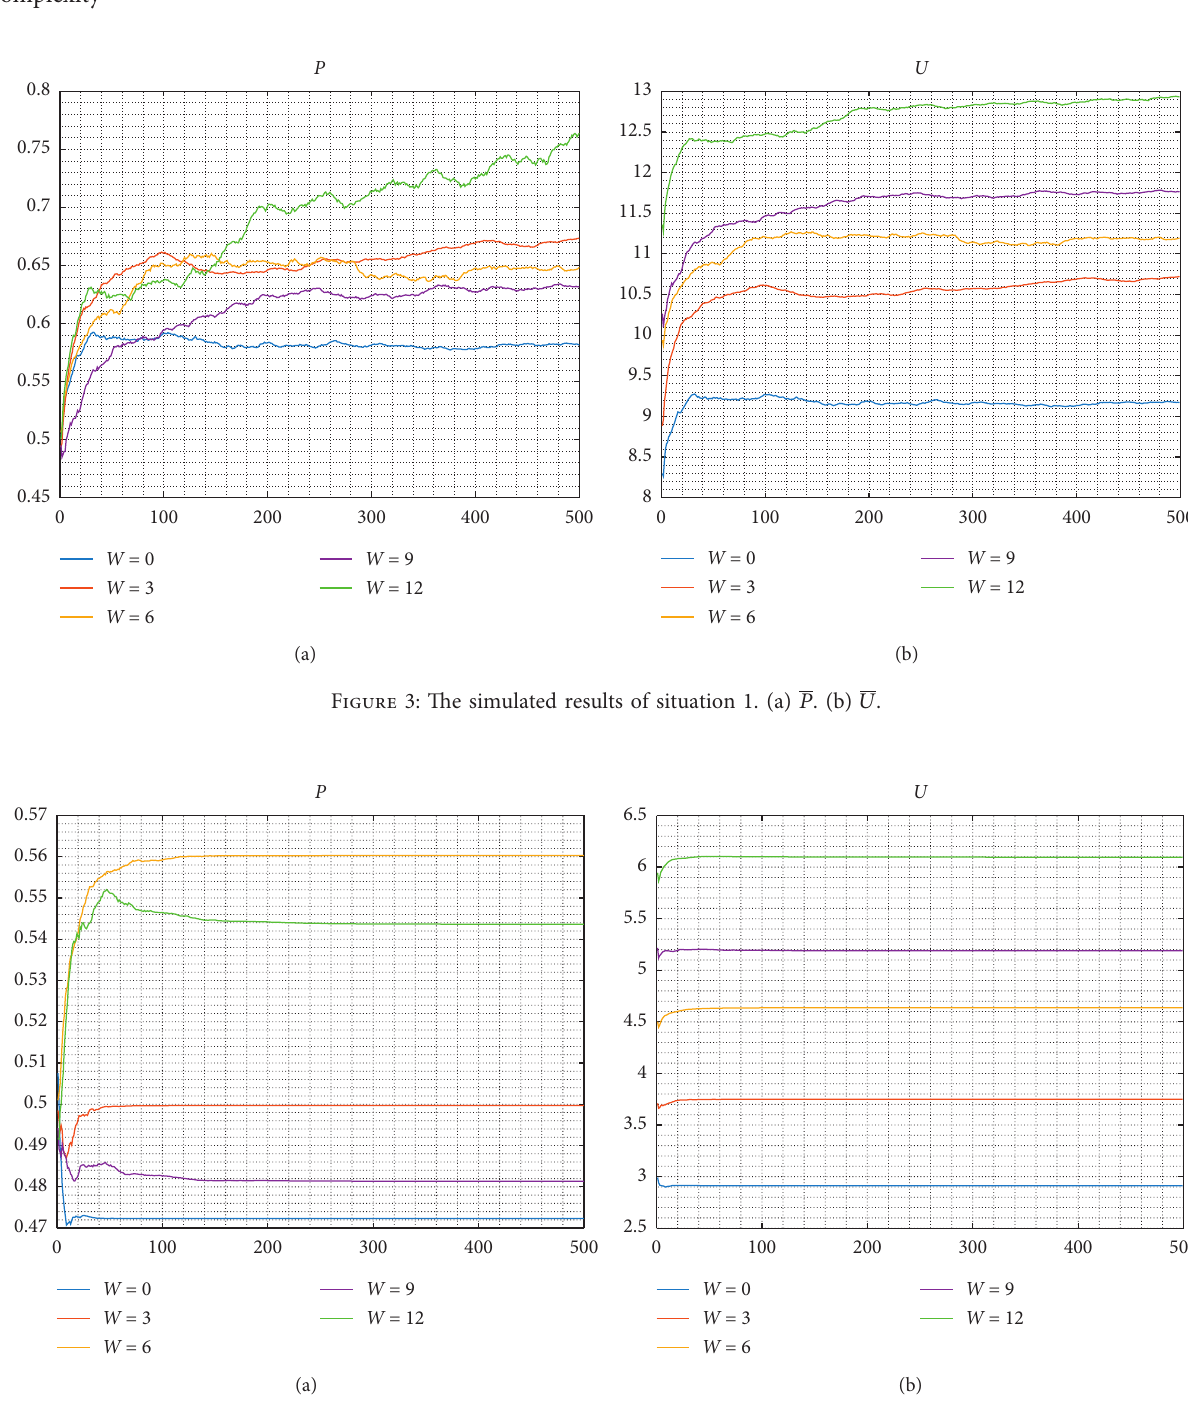
Figure 4: The simulated results of situation 2. (a) P . (b) U . Table 5: Parameter setting of situation